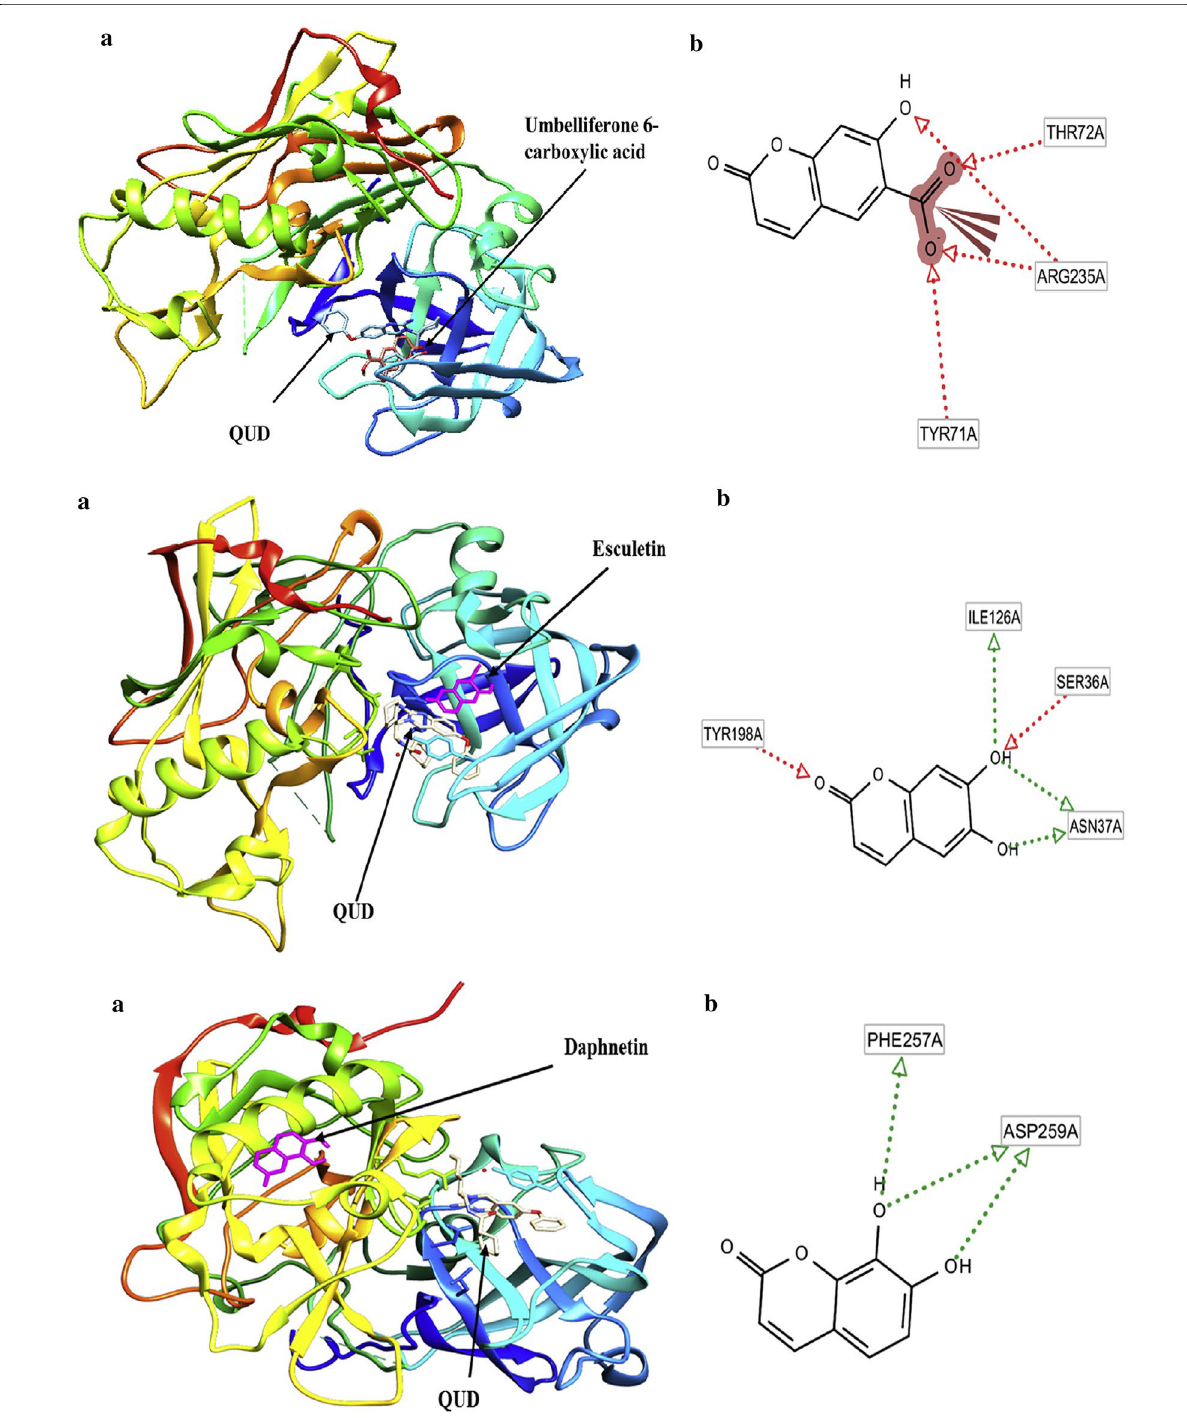
Fig. 83 a Molecular docking model BACE1 with C94b , C94h and C94j : ( b ) Diagram of the ligand interaction of C94b , C94 h and C94j in the active site of BACE1